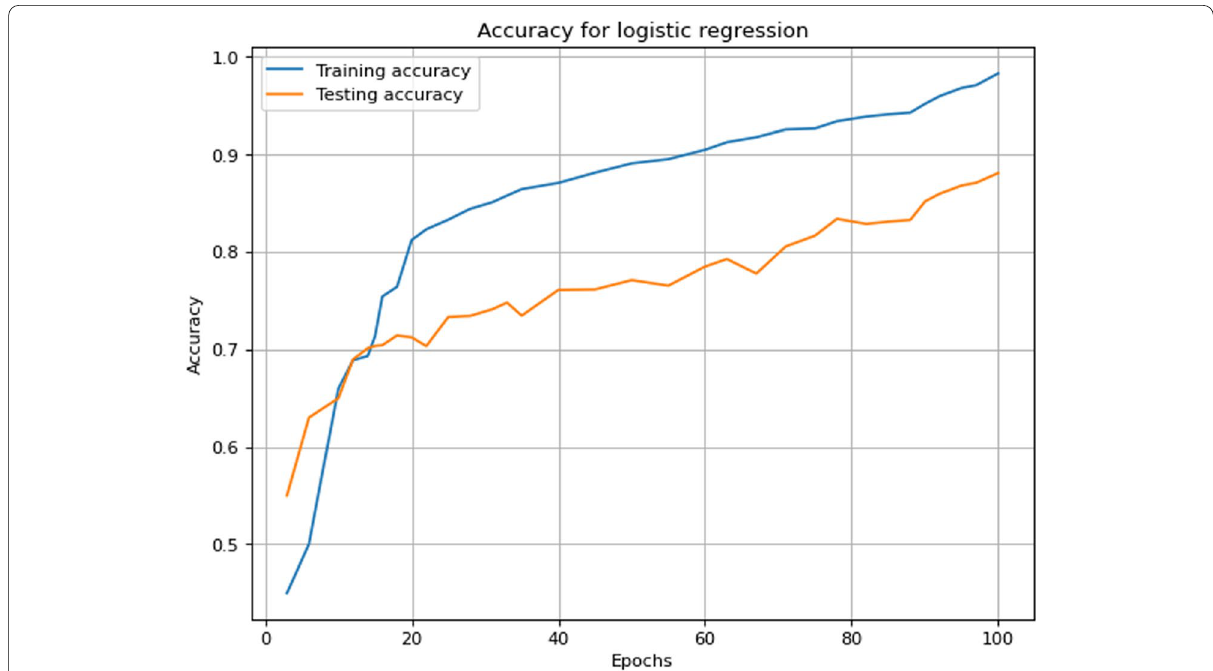
Fig. 20 Accuracy for our proposed model with logistic regression